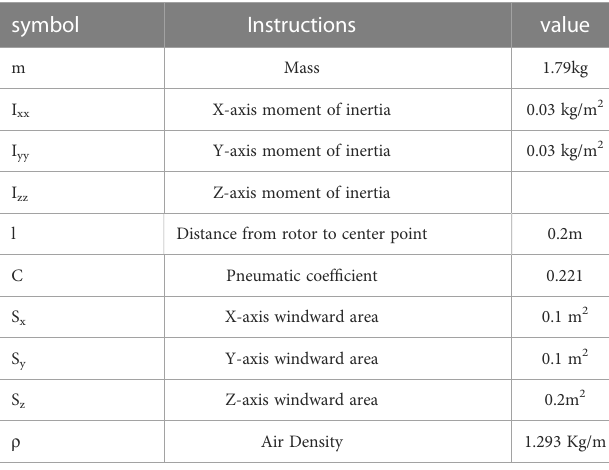
TABLE 2 UAV parameters (Shen et al., 2021; Lotufo et al., 2020).